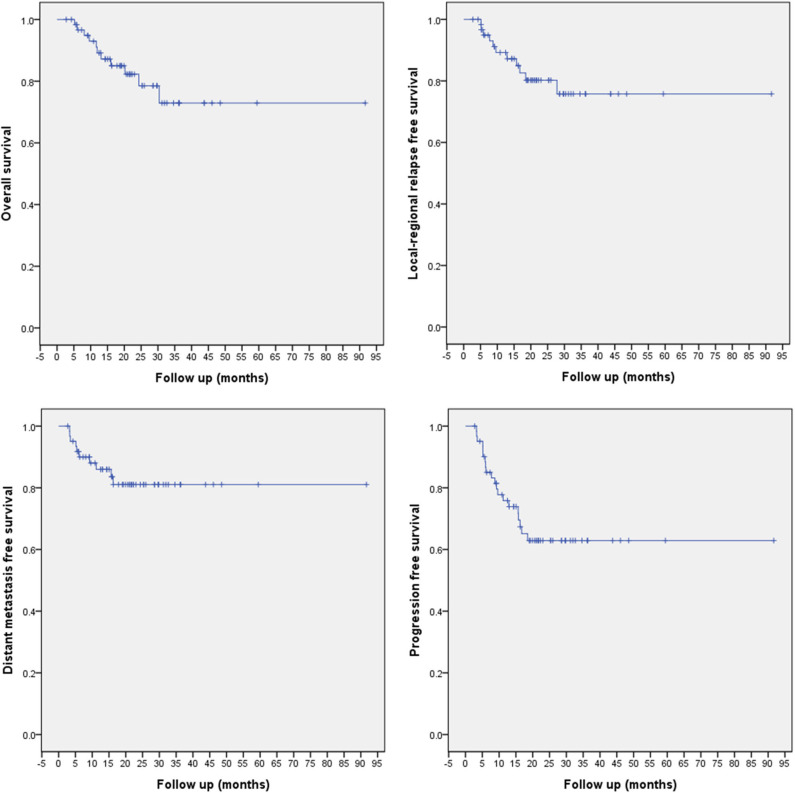
OS, LRFS, DMFS, and PFS of the entire cohort of 62 SBS patients treated with PBRT.